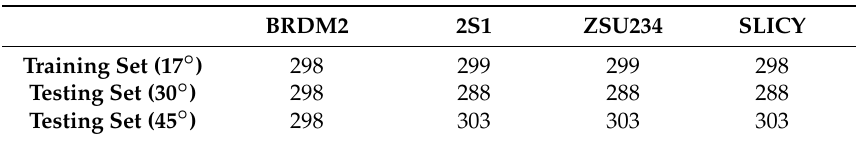
Figure 18. Example SAR images of four targets. ( a ) BRDM2; ( b ) 2S1; ( c ) ZSU234; ( d ) SLICY. Table 2. Dataset used in the experiment.